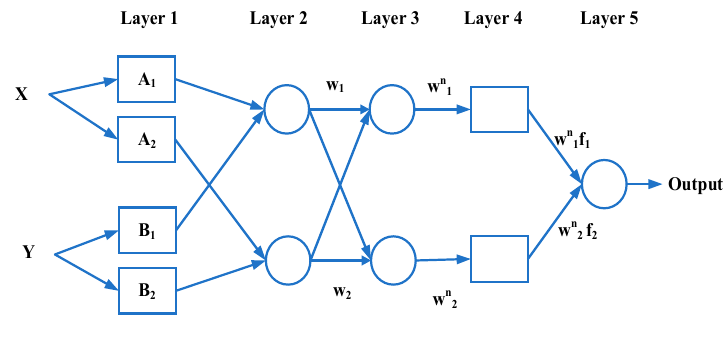
Figure 3. The adopted ANFIS structure.